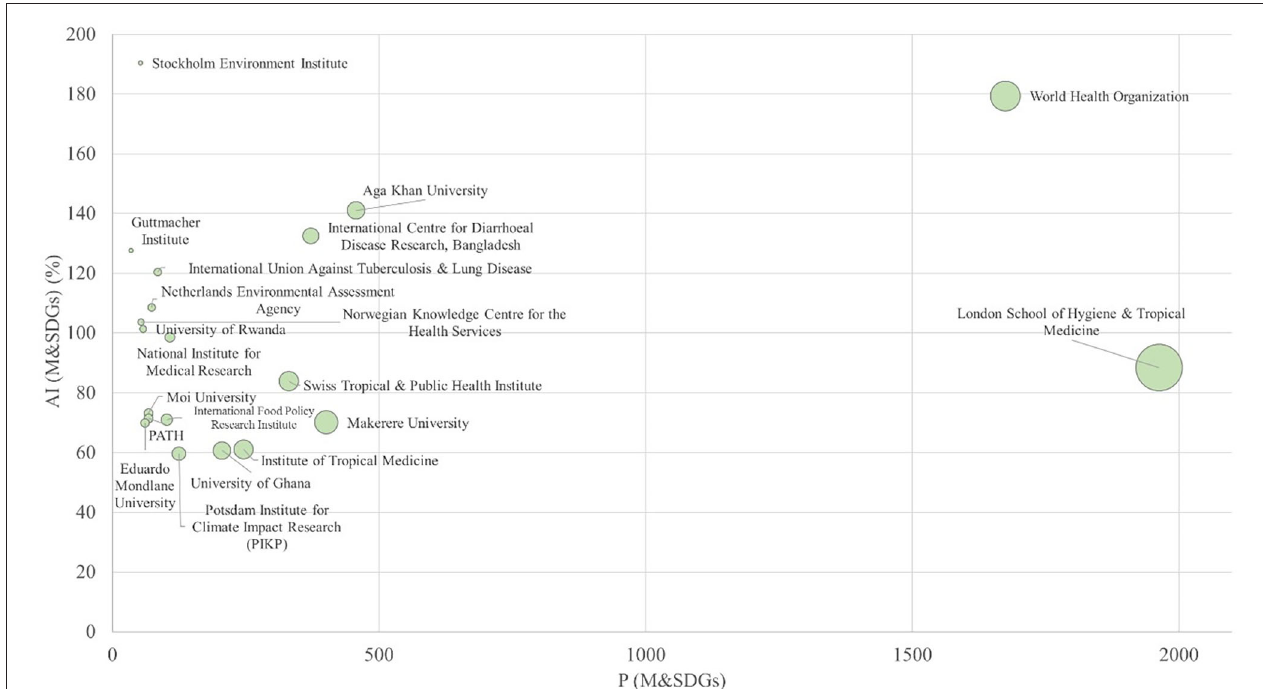
FIGURE 3 | Scatter plot of the Top 20 organizations ranked by AI (with more than 50